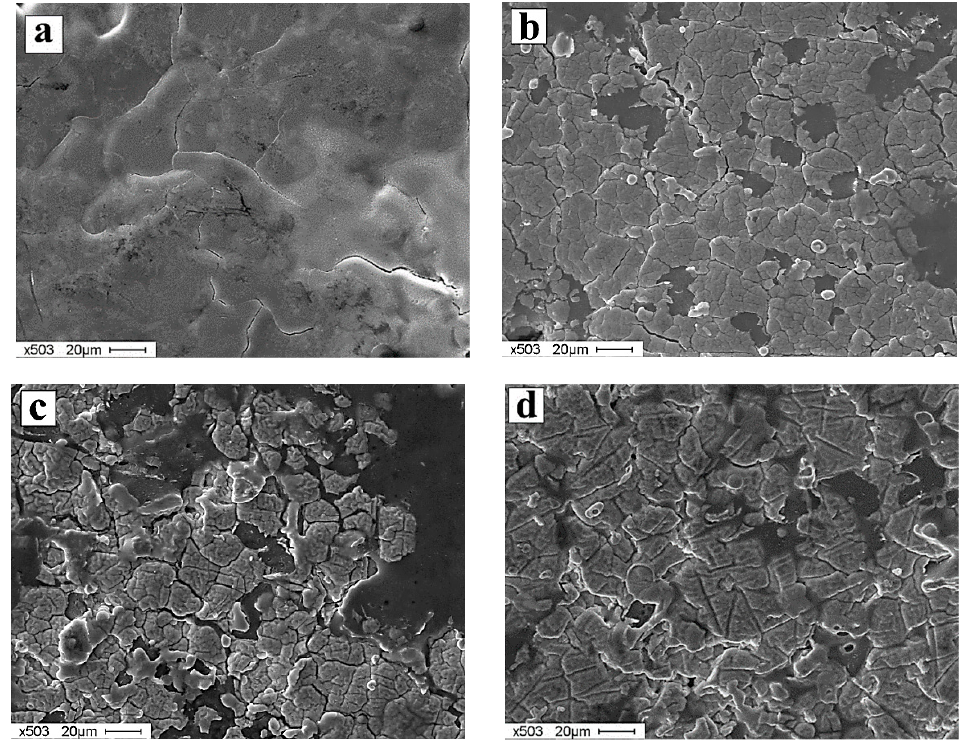
Figure 2. SEM images of the surface structure of the bare and ZrN-coated silumin after electron beam treatment: sample 1 (no coating) ( a ), sample 2 (h ZrN = 0.5 μ m) ( b ), sample 3 (h ZrN = 1 μ m) ( c ), and sample 4 (h ZrN = 2 μ m) ( d ).